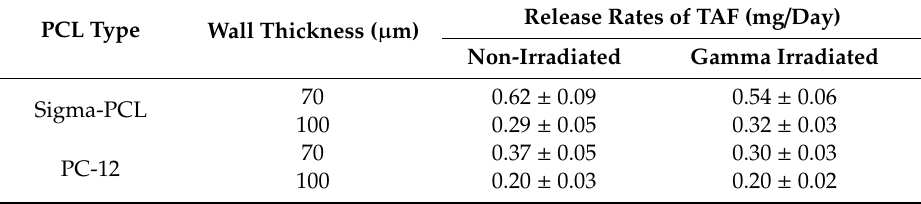
Table 3. Daily TAF release rates from implants pre- and post-gamma